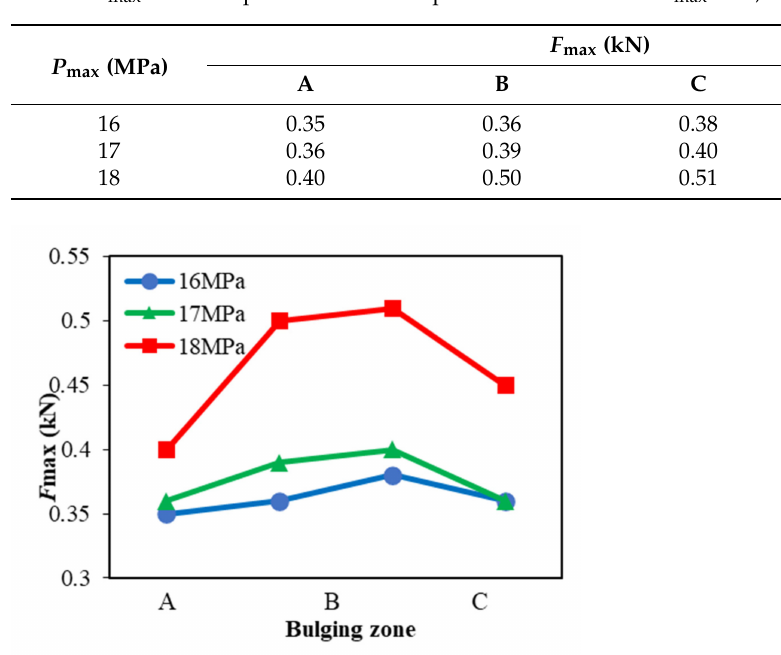
Table 5. F max that each part of the test sample could withstand at P max = 16, 17, and 18 MPa.